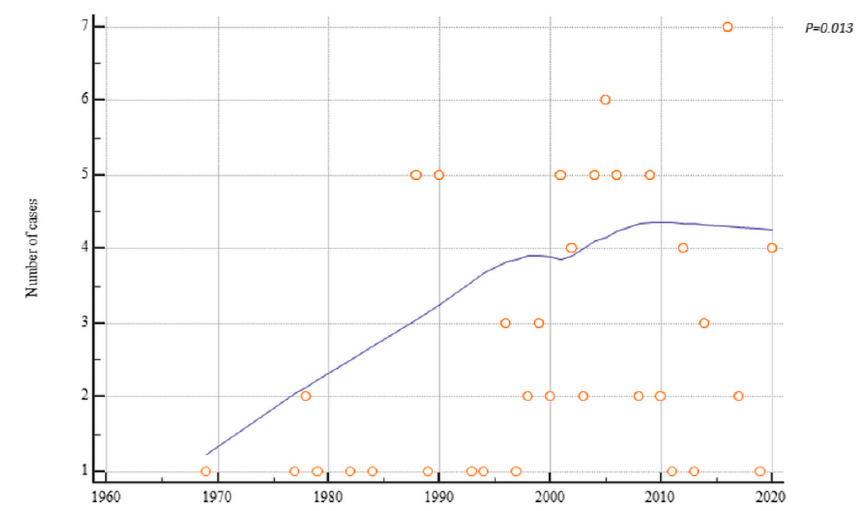
Figure 4. Scatter diagrams showing the trend over time of postmenopausal endometriosis transformation